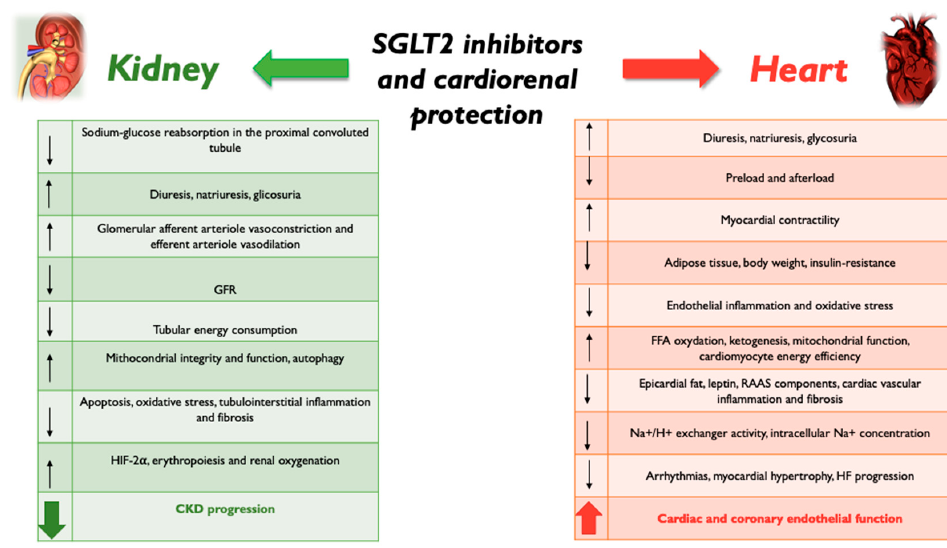
Figure 1. SGLT2-Is cardiorenal protection mechanisms.